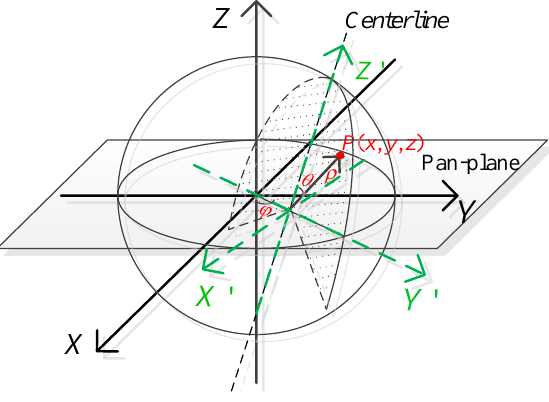
Figure 4. Coordinate system in the ideal situation.